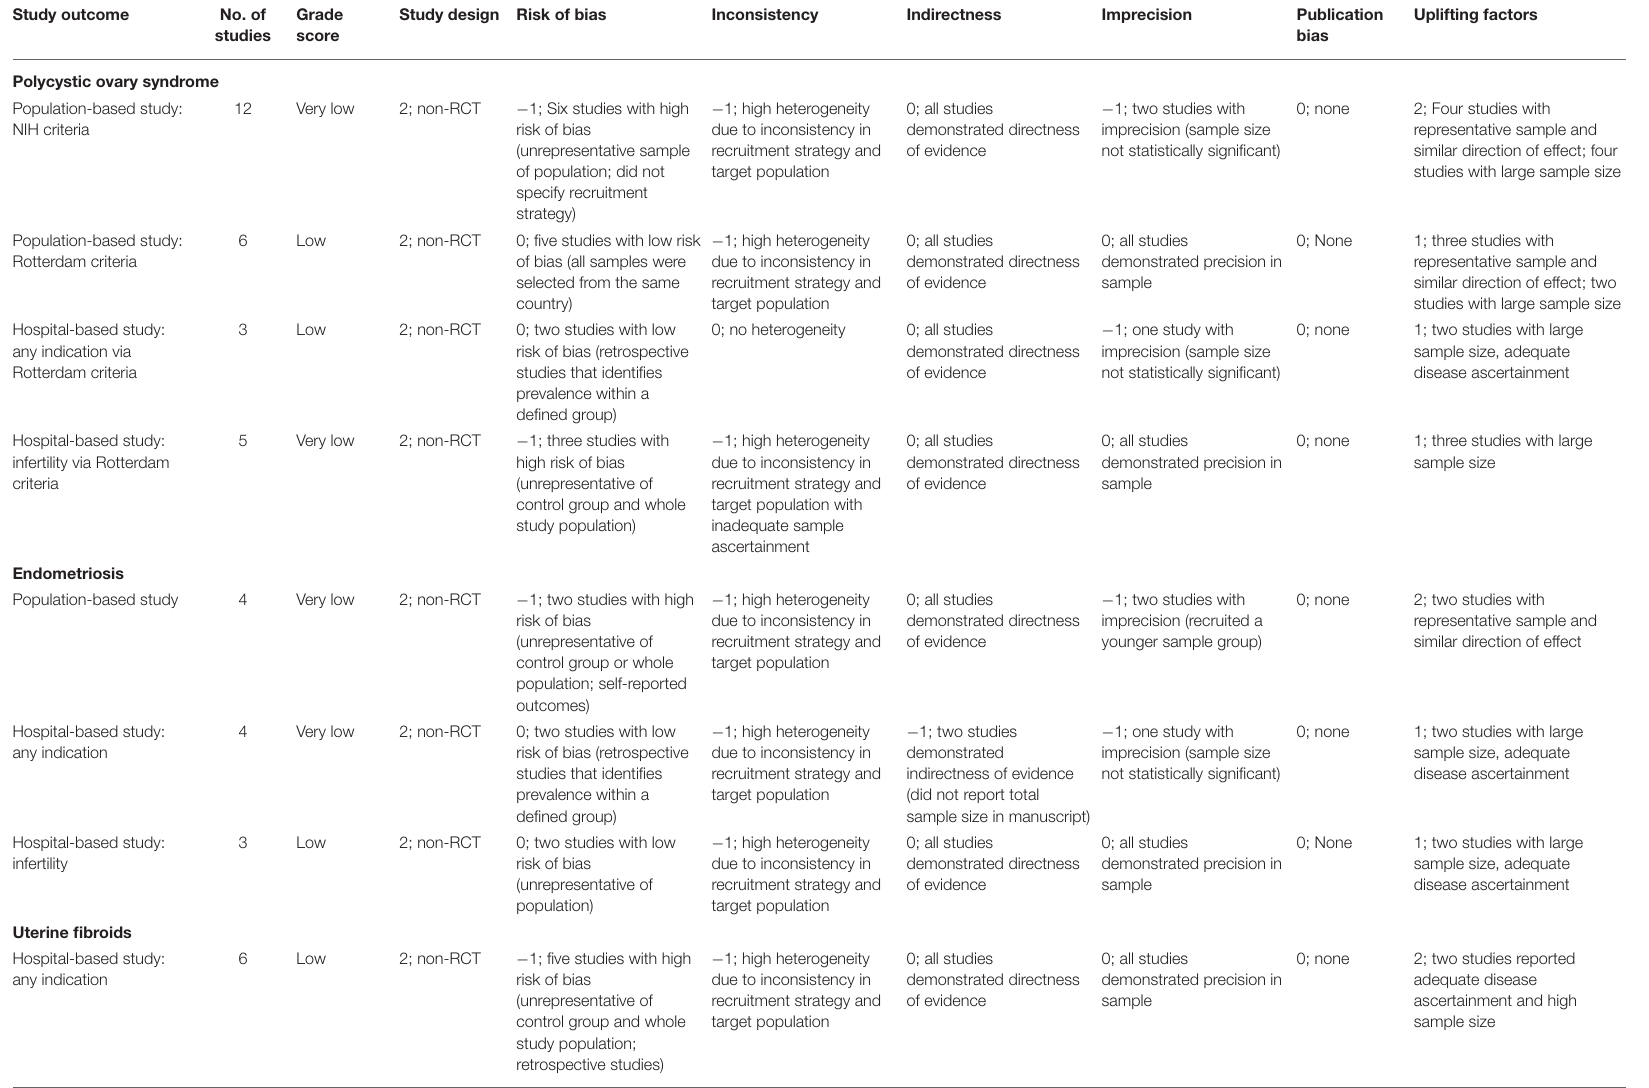
TABLE 3 | Summary of the quality assessment of the studies reporting the outcomes of interest included in the